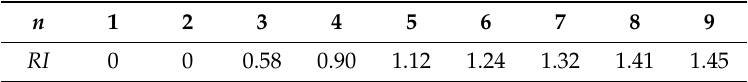
Table 3. Random indicator ( RI ) values corresponding to the comparison-matrix dimensions. n